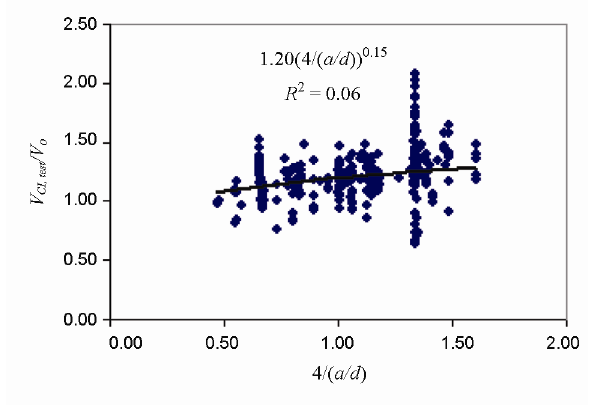
Fig. 2. Effect of slenderness ratio on cracking shear